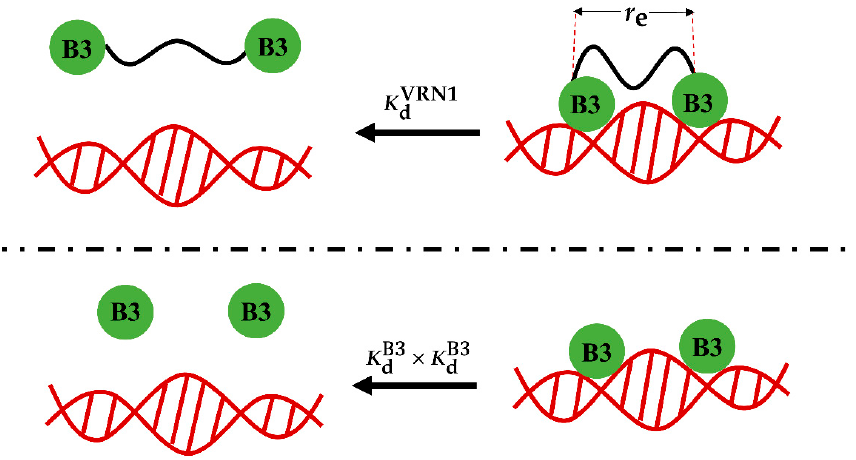
Figure 1. Schematic diagram of C eff calculations. Top: two B3 domains in VRN1 bind to DNA cooperatively, the dissociation constant of which can be quantitated by K d VRN1 . r e denotes the end-to-end distance of the linker in the binding complex. Bottom: two B3 domains bind to DNA independently, the dissociation constant of which can be quantitated by K B3 VRN1 provides effective local concentration to enhance the binding of VRN1 to DNA, which can be B3 × K B3 d quantitated by the ratio of K d K VRN1 d